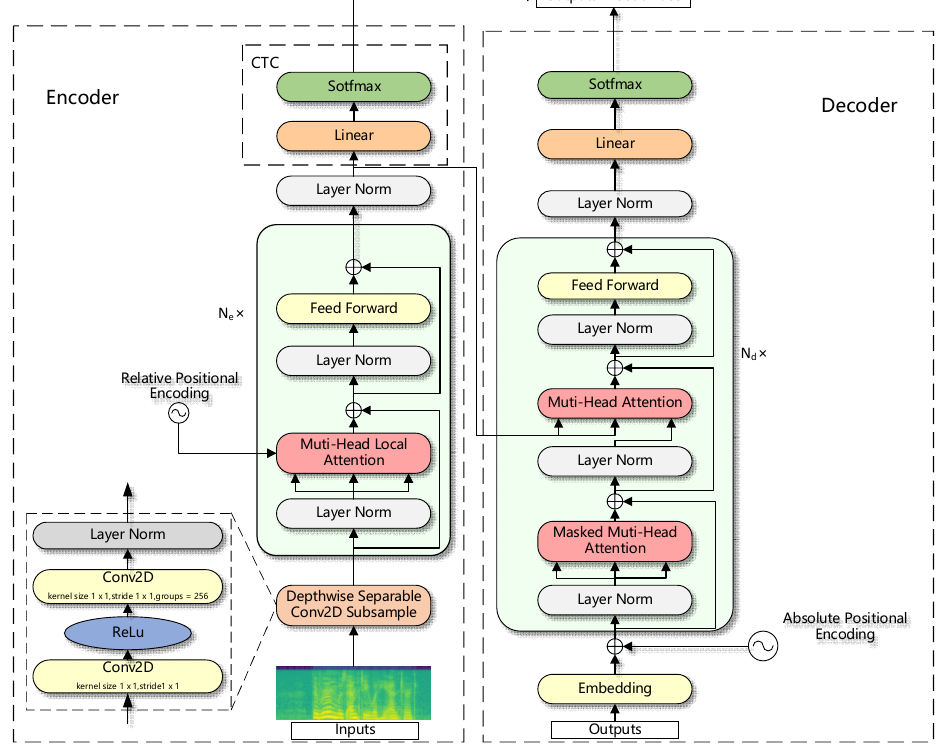
Figure 1. The overall framework of the LAS-Transformer.